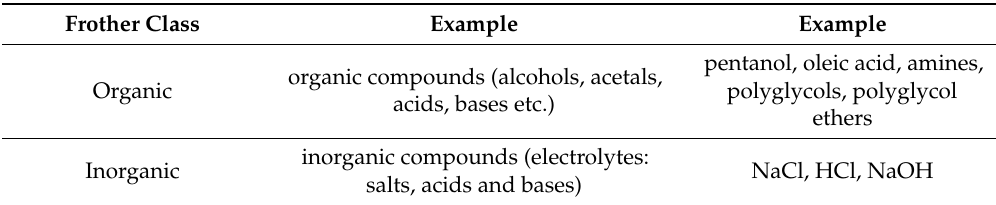
Table 2. Classification of frothers into organic and